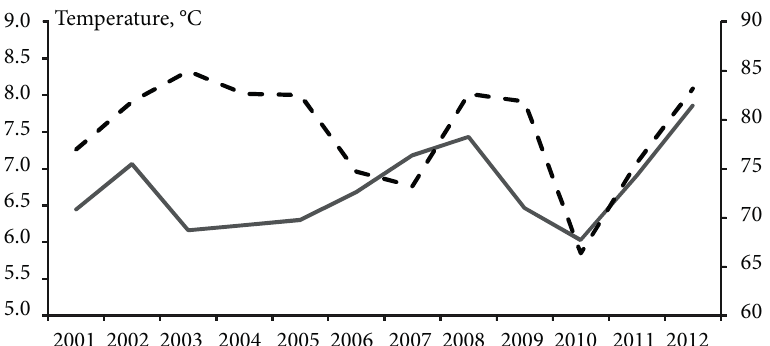
Fig. 2. Annual average values in 2001–2012 in Vilnius: cardiovascular diseases (-----),